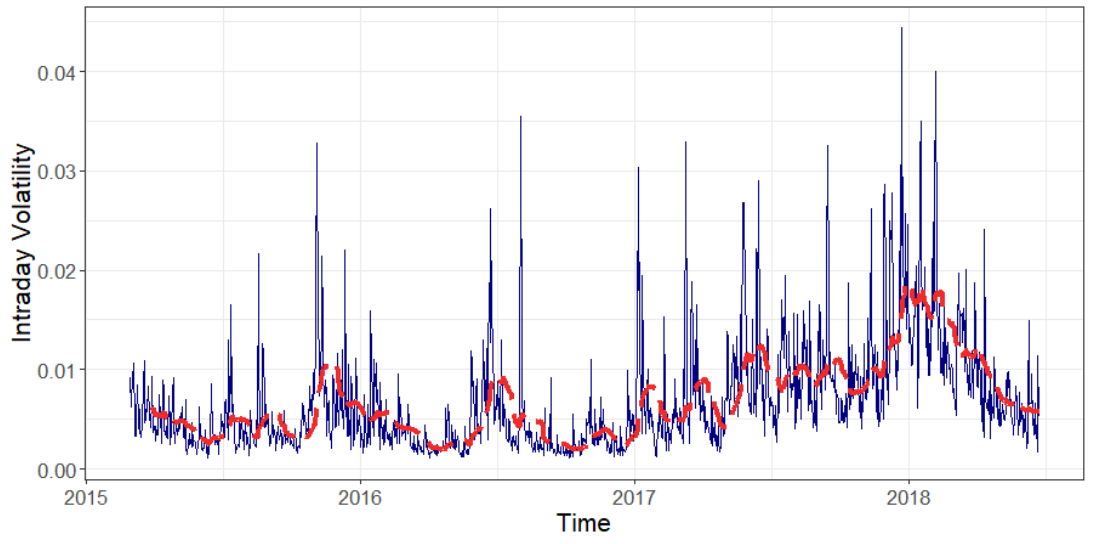
Fig. 2. Intraday hourly volatility index for Bitcoin returns (denominated in US dollars). Each point in the series represents the average volatility for the day. The dashed red line depicts the corresponding rolling 30-day